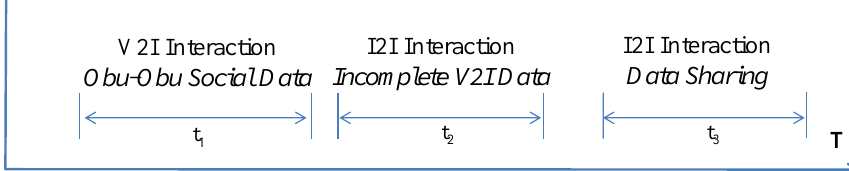
Figure 5. An example timeline of infrastructure storage, ψ